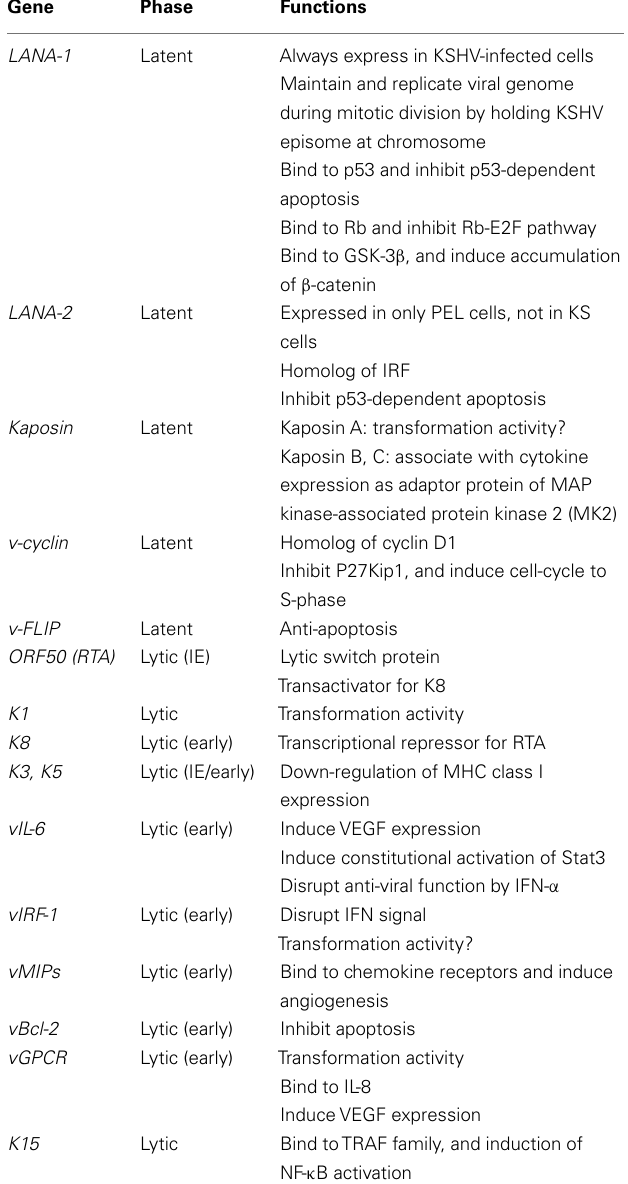
Table 1 | Kaposi’s sarcoma-associated herpesvirus genes and their